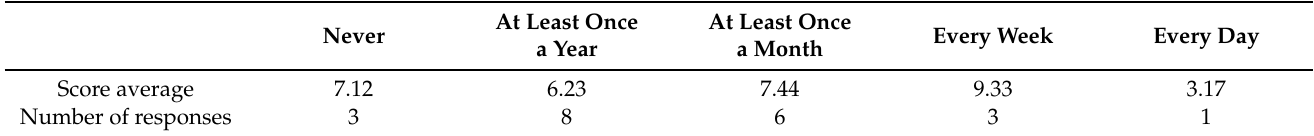
Table 4. Average knowledge test results depending on the frequency of using VR technology: How often had the respondents used